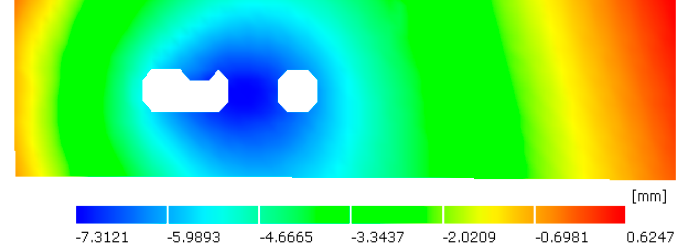
Figure 13. Welding distortion of a plate with arc blowout (DIC camera viewing from plate backside).